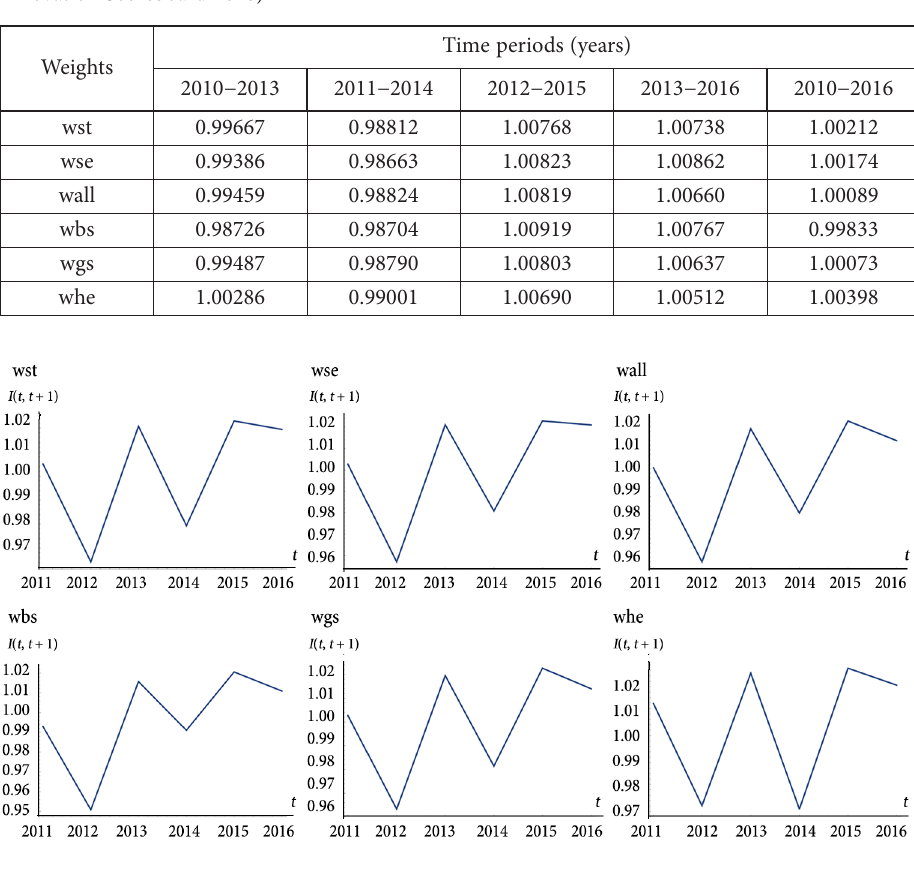
Figure 4. The one-year innovativeness changes depending on the system of weights and calculated for the V-4 (source: own elaboration based on the data of the European Statistical Office – Eurostat and European Commission, 2018. European Innovation Scoreboard